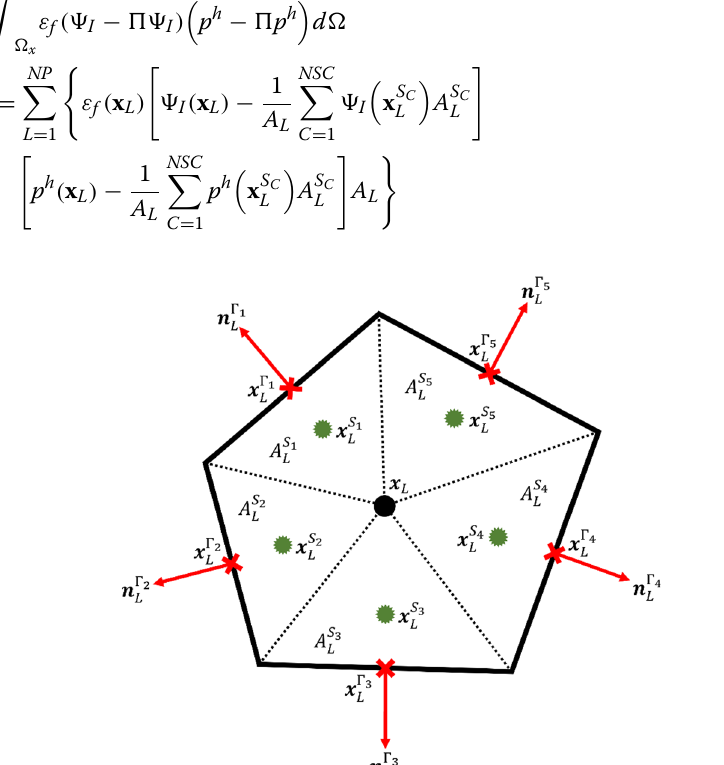
Fig. 5 Example of a conforming nodal cell centered on node L and located at x L ; shape functions for calculating smoothed gradients are evaluated at the center of each nodal boundary segment, x Ŵ i L , which have outward normals n Ŵ i L ; shape functions for calculating the pressure projection are evaluated at the centroids of the sub‑cells, x S i L ; the sub‑cell areas are denoted by A S i